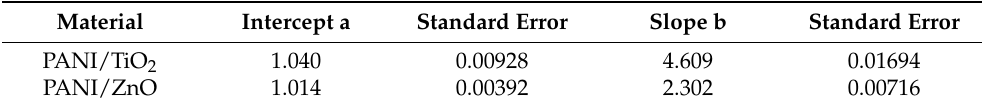
Table 5. Fitting results of curves in Figure 11 using Equation (14).